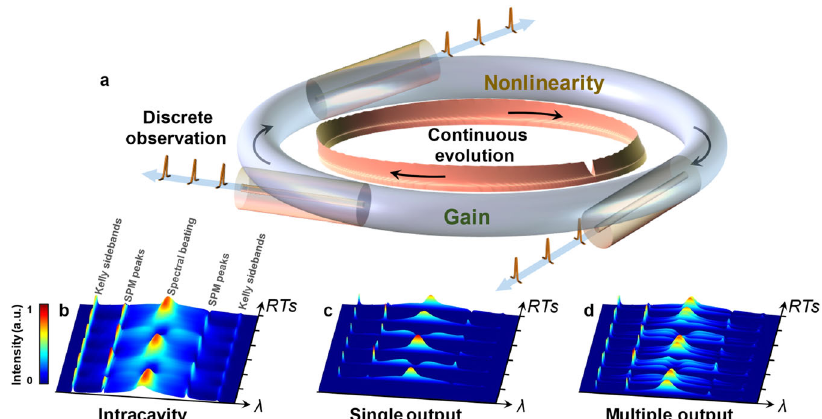
Fig. 1 Principle of multi-port real-time observation. a Soliton evolves continuously in the cavity and ( b ) the spectral beating process of intracavity soliton from simulation (the detailed simulation parameters are shown in Table 1). RT: round trip. c Discrete observation by single output re fl ects an incomplete spectral beating process and ( d ) Multiple output observation increases the sampling rate to show details of the soliton evolution